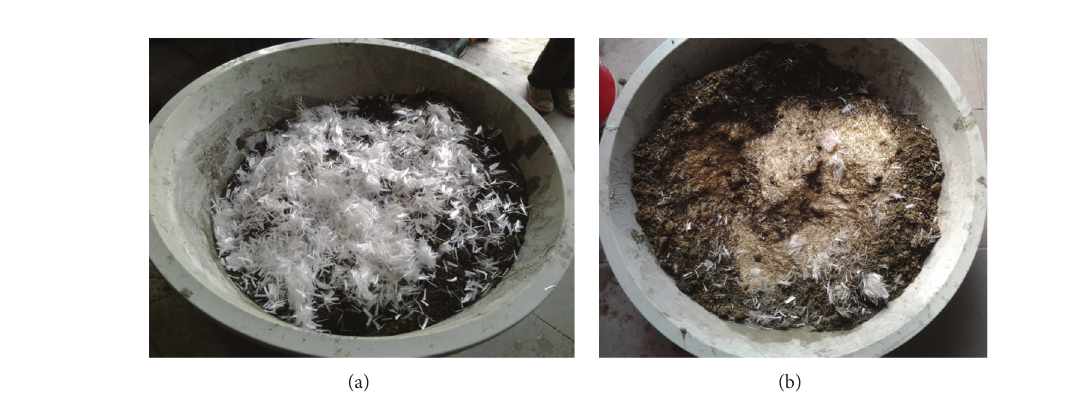
Figure 5: Upper and lower hoods.